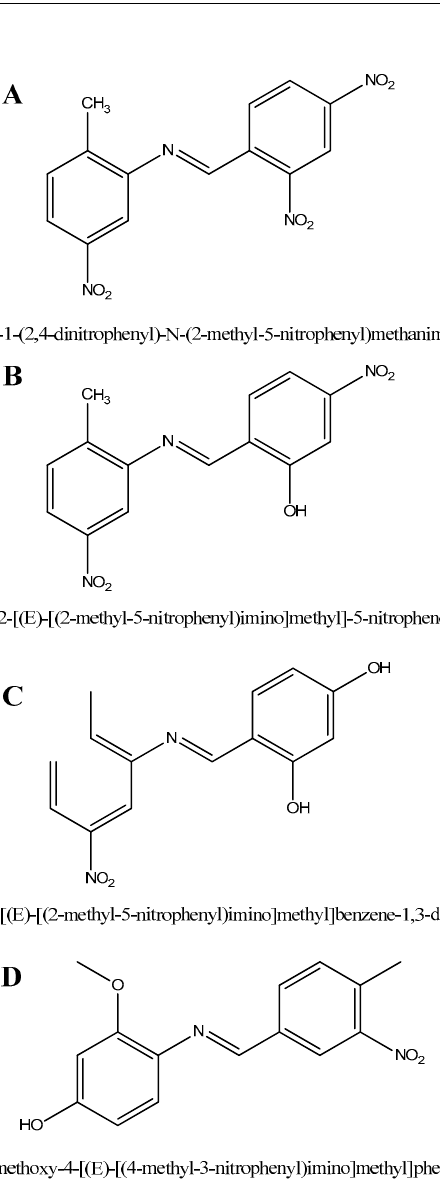
Figure 7 . Possible side products of the TDA synthesis according to Hajdu et al.’s research (black line—detected molecules, blue line—assumed molecules) [44].